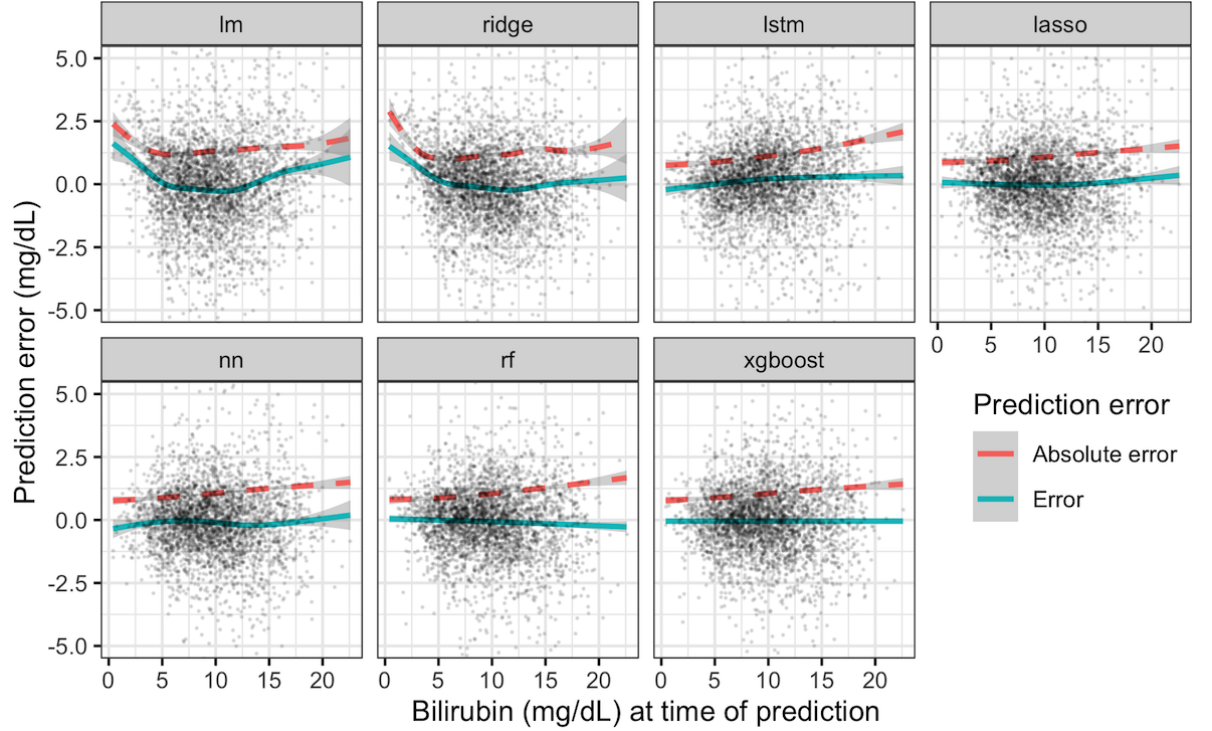
Figure 2. Model prediction errors versus bilirubin level at time of prediction. Each panel depicts the performance of a single predictive model, as described in Textbox 1. Each point represents the error of a single prediction in the test set (n=3320, over 98% visible within ±5 mg/dL error). The curves show the smoothed mean error (blue solid) and mean absolute value of error (red dashed); the gray band is the 95% CI of the